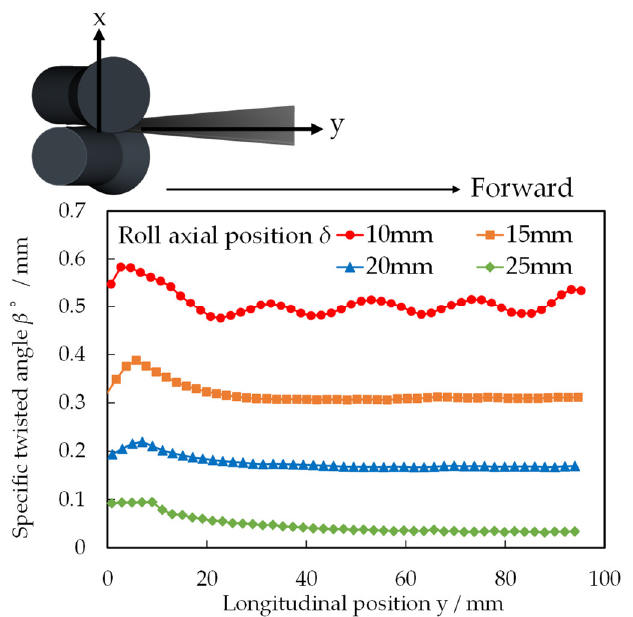
Figure 12. Movement of the contact point to the sheet metal.